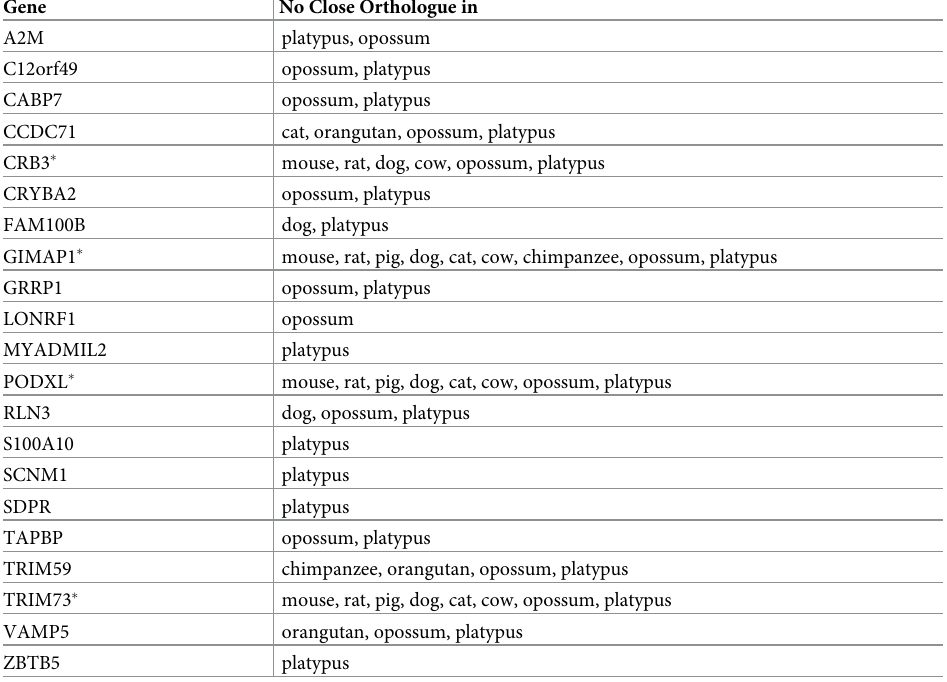
Table 1. Overall differences between 10 vertebrate species and human with respect to the 21 non-uniformly con- served human proteins in EC only. ( � denotes absence of mouse orthologue, 4 out of 21). Gene No Close Orthologue in A2M platypus, opossum C12orf49